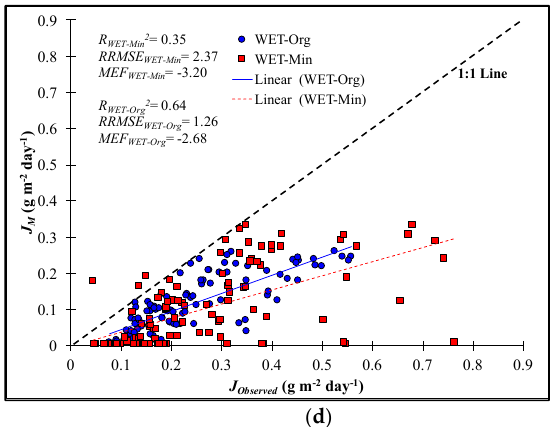
Figure 2. Relationship between observed and predicted wetland mesocosm average NO 3 -N removal rates determined using ( a ) zero order, ( b ) First Order Decay, ( c ) Efficiency Loss, and ( d ) Monod kinetic models. Rate constants used in calculations were adjusted for daily average water temperature. Statistical acronyms represent: Coefficient of determination ( R 2 ), Relative root mean square error ( RRMSE ), and Model efficiency ( MEF )). Kinetic acronyms represent: Zero order (ZO), first order decay (FO), efficiency loss (EL), and Monod (M) models.